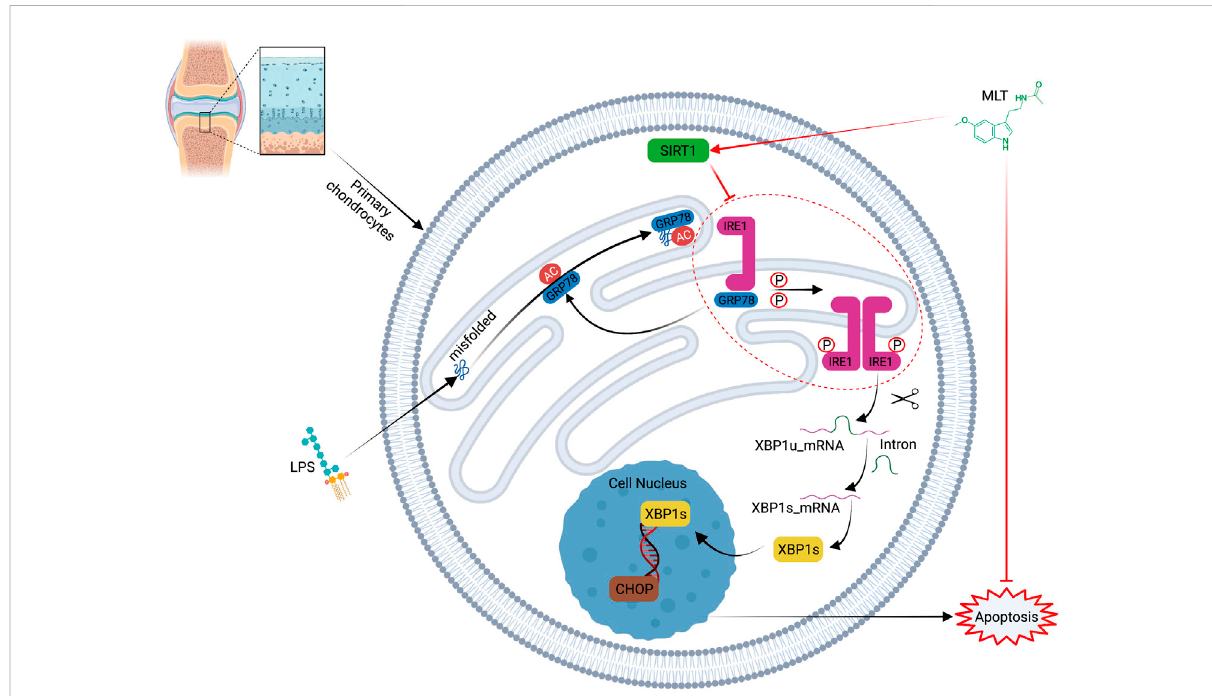
FIGURE 9 Schematic illustration of the mechanism of melatonin ’ s protective effects against lipopolysaccharide – treated human